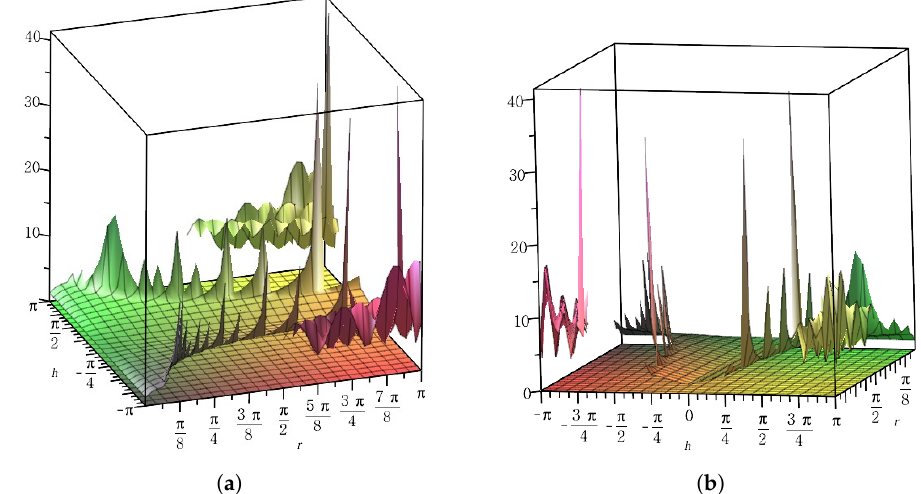
Figure 7. ( a ) Three-dimensional (3D) graph showing both zero and Err ( f ( z ) , z 0 ) when h ( − π ≤ h ≤ π ) and r (0 ≤ h ≤ π ) are changed independently of each other. ( b ) Contour line drawn on a plane to estimate the distribution and magnitude of the relative error Err ( f ( z ) , z 0 ) according to h and r in the 3D graph of ( a ).